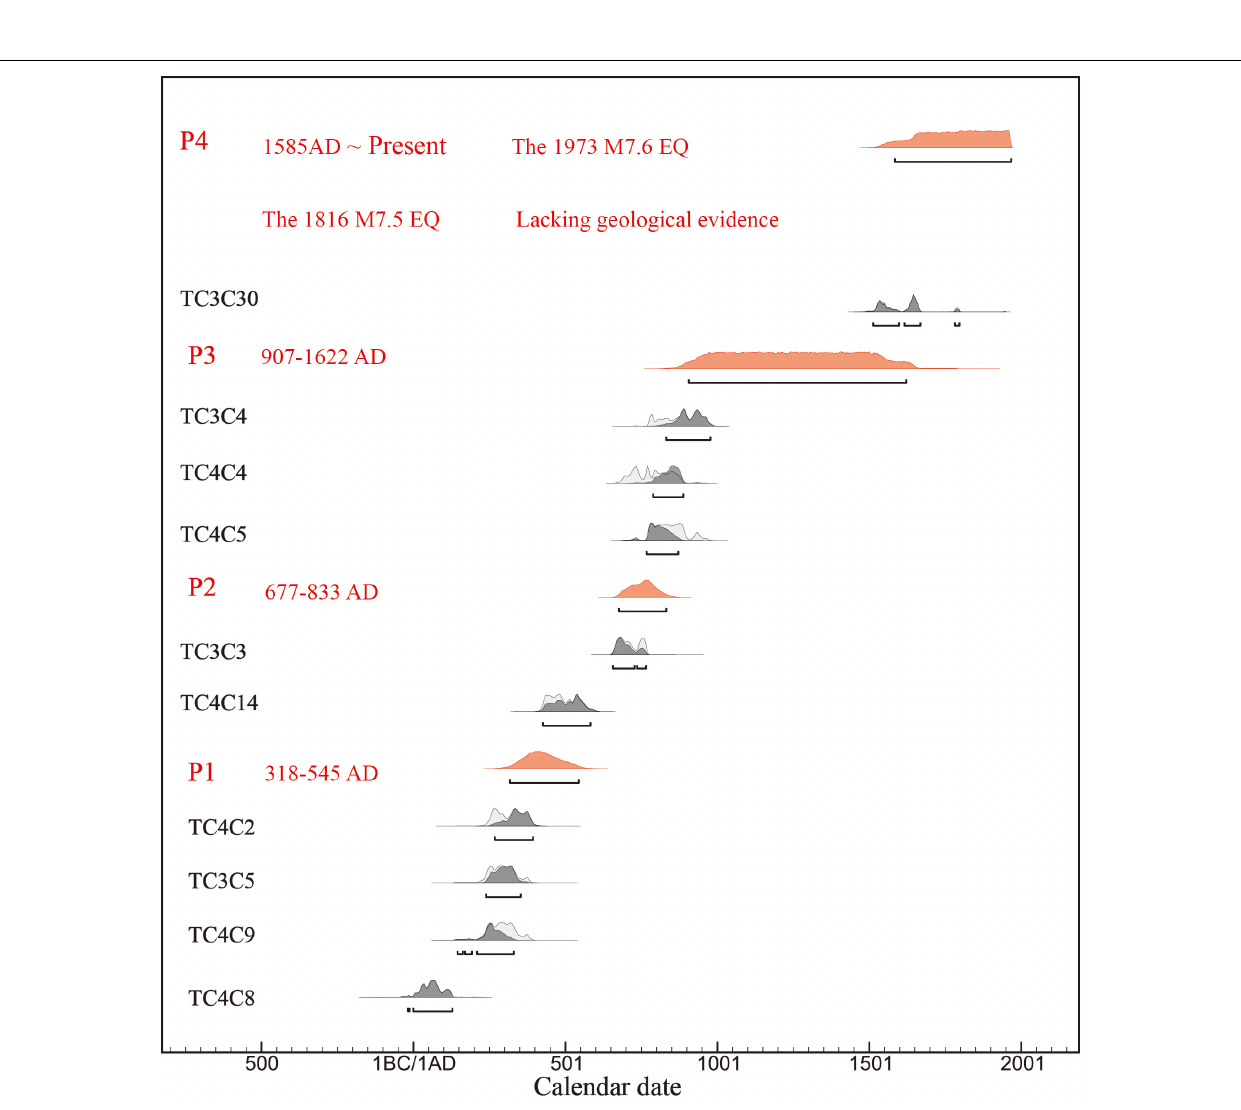
Frontiers in Earth Science |